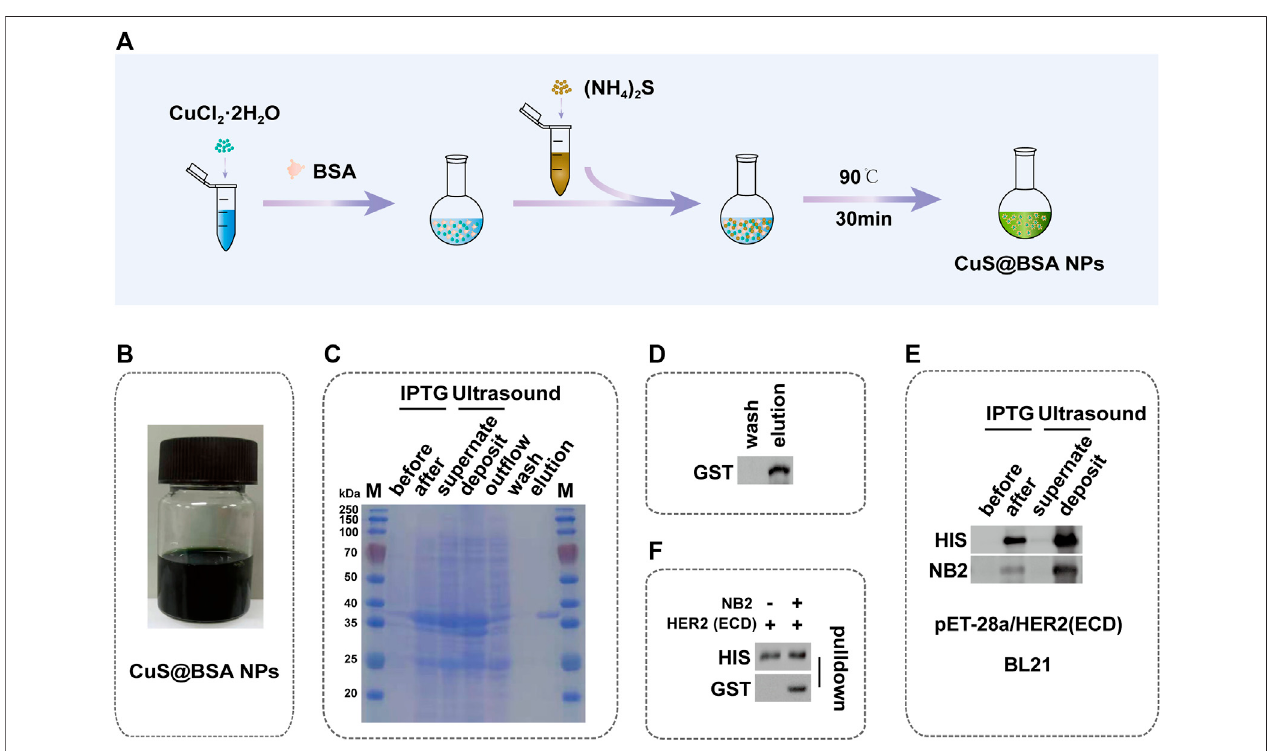
FIGURE2| SynthesisofCuS@BSANPsandIdenti fi cationofNB2. (A) SchematicdiagramofthesynthesisprocessofCuS@BSANPs. (B) Thesynthesizedsolution ofCuS@BSA NPs. (C) SDS-PAGE image oftheexpression and puri fi cation ofNB2.Themolecular weightofNB2was38 kDa showedinthe elutionlane.M:marker. (D) Western blot of NB2 expression and puri fi cation. (E) Western blot of induction and expression of HER2 ECD protein in BL21-DE3 and the NB2 recognizing HER2 ECD protein. (F) Western blot of NB2 and supernatant of being induced and broken of HER2 ECD protein